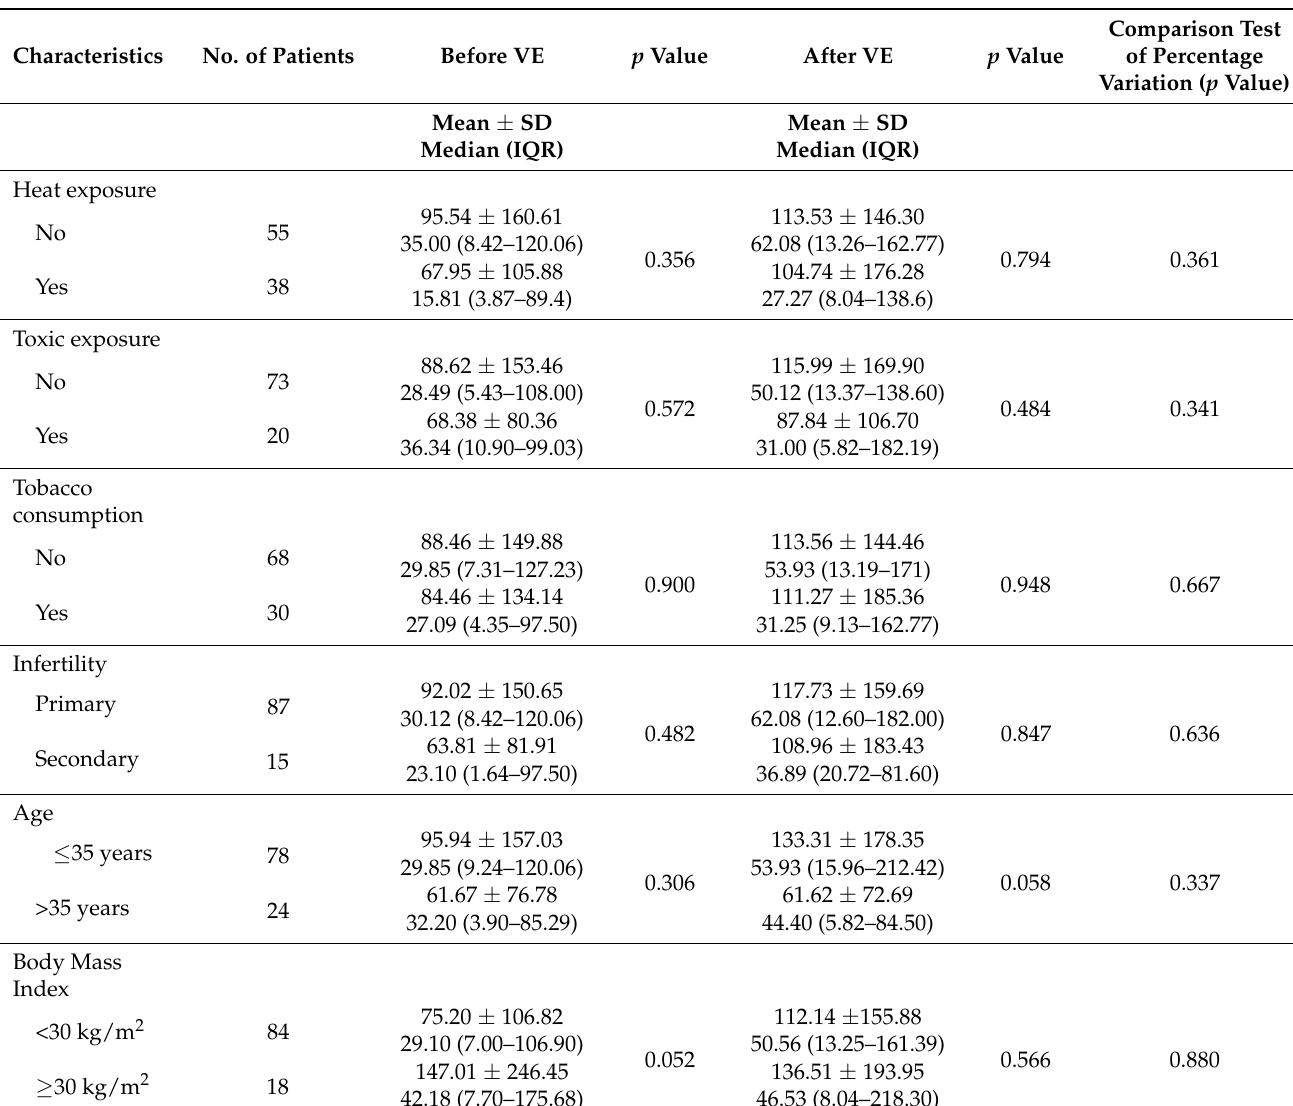
Table 4. Impact of patients’ characteristics on the total sperm number (TSN) (10 6 /ejaculate) before and after varicocele embolization